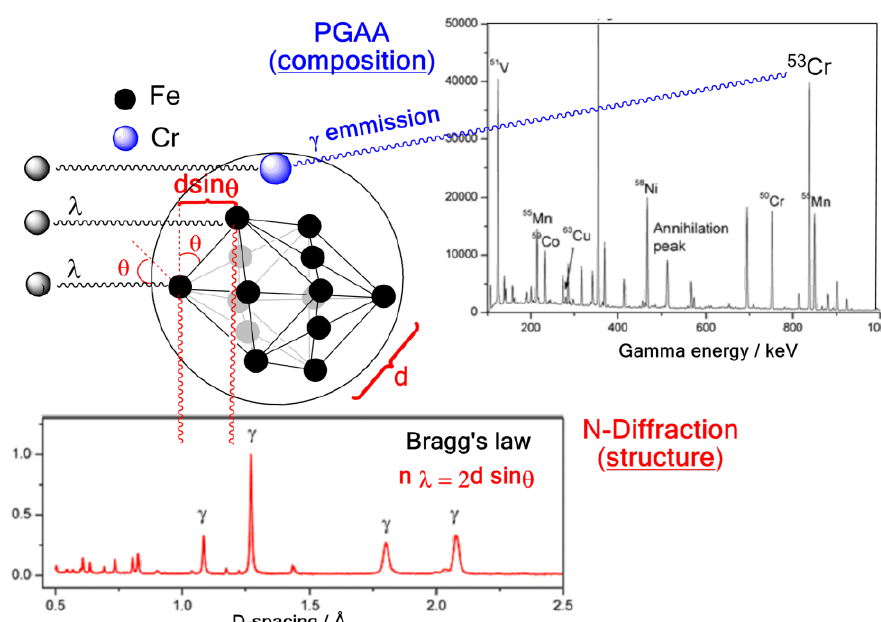
Figure 2. Schematic of simultaneous prompt gamma activation analysis (PGAA) and neutron diffraction measurements carried out. PGAA elemental measurements ( upper ) reveal constituent elements and isotope content, whilst diffraction ( lower ) resolves the d-spacing of the differing γ austenite and α’ martensite phases present and their relative fractional content.